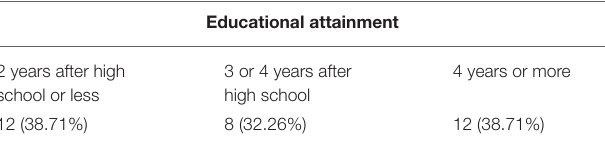
TABLE 2 | Description of the educational attainment of